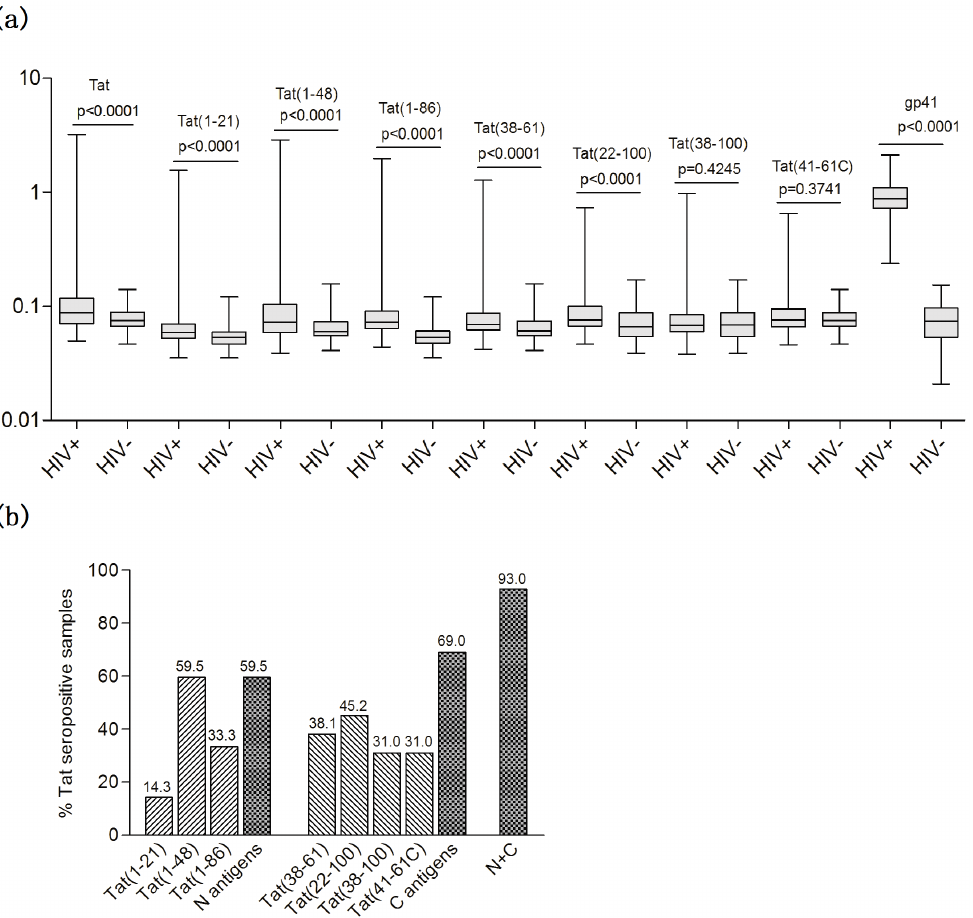
Figure 2. Characterization of antibody responses to full-length Tat and seven Tat peptides. (a) A comparison of the antibody reactivity against Tat of the seven analytic Tat peptides and gp41 in Chinese individual infected with HIV-1. Recombinant subtype B full-length Tat protein and six Tat peptides were used in the assays. The gp41 commercial kit used a pool of peptides representing the immunodominant epitopes in the ectodomain of gp41. The boxes represent the interquartile range, the line inside each box represents the median of the samples and the whiskers represent the range of the data. Statistical significance was tested using Wilcoxon non-parametric test. (b) Characterization of antibody responses to various antigens. The positive rate of antibody response was plotted on the y-axis with the seven antigens on the x-axis. The positive rate corresponding to the N antigens represented the total positive rate of antibody responses detected by Tat(1–21), Tat(1–48) and Tat(1–86) in the 42 anti-Tat-seropositive samples (details were showed in Fig. 3a). The positive rate corresponding to the C antigens represented the total positive rate of antibody responses detected by Tat(38–61), Tat(22–100), Tat(38–100) and Tat(41–61C) in the 42 anti-Tat-seropositive samples. The positive rate (39/ 42) corresponding to N + C represented the total positive rate of antibody responses detected by the N antigens (25/42) and specific antibody responses only detected by the C antigens (14/42).